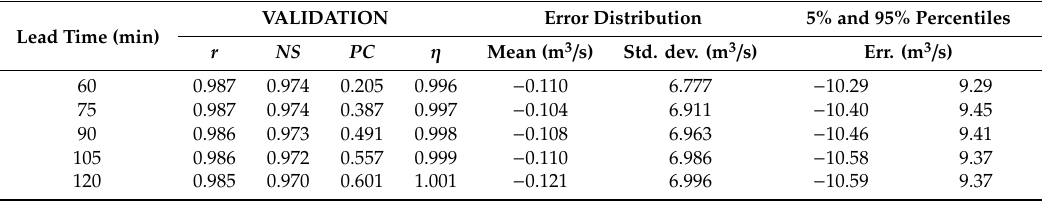
Table 3. Model-1 performance evaluation coefficients and forecasting error statistics (validation data